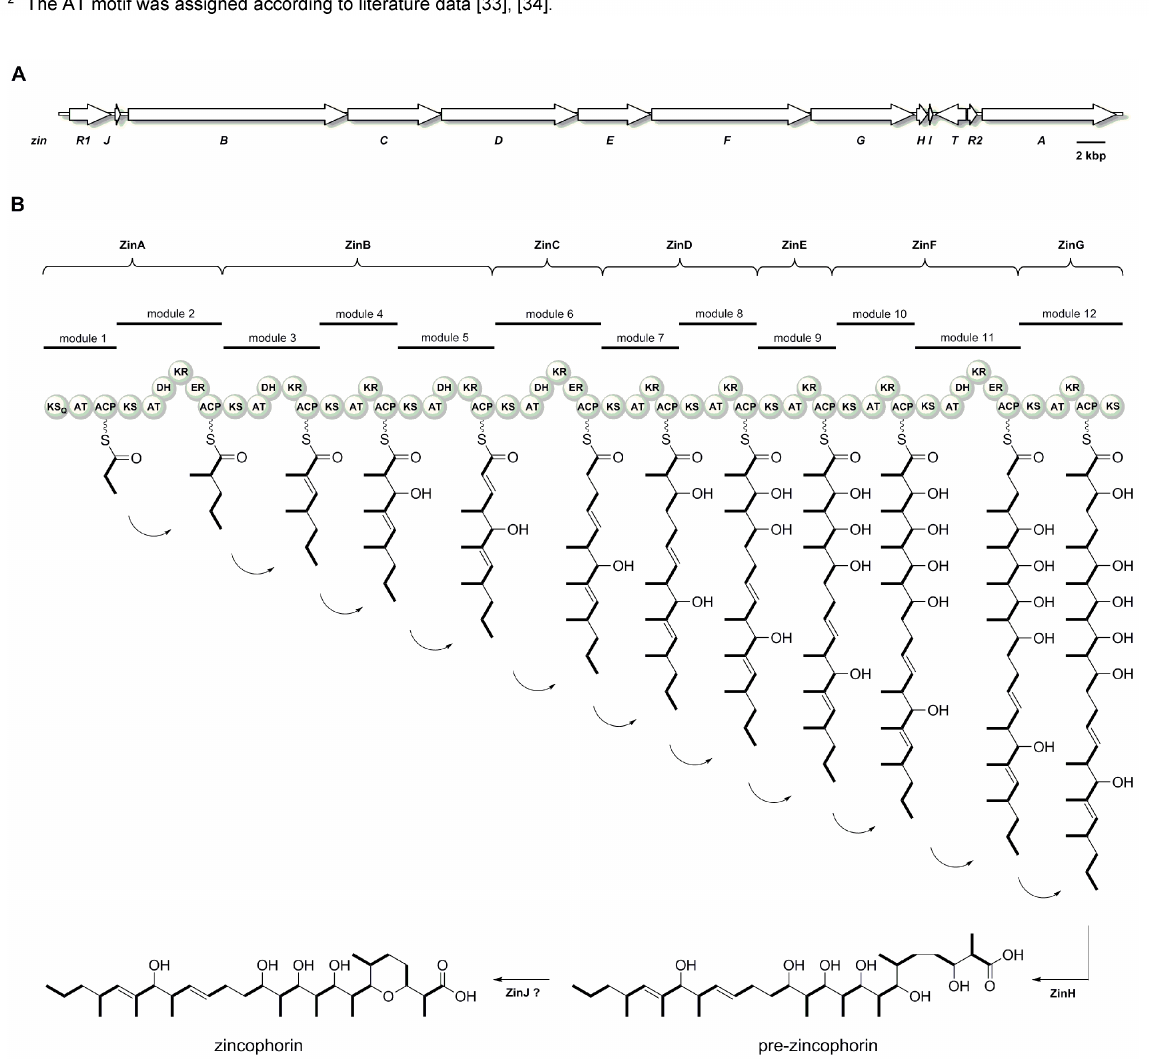
Figure 2: (A) Organization of the zincophorin biosynthesis gene cluster. (B) Molecular assembly line deduced from zinAto zinG and proposed biosynthesis of zincophorin via the intermediate pre-zincophorin. The acyl-CoA-derived C are highlighted in bold. The domain notation is given in Table